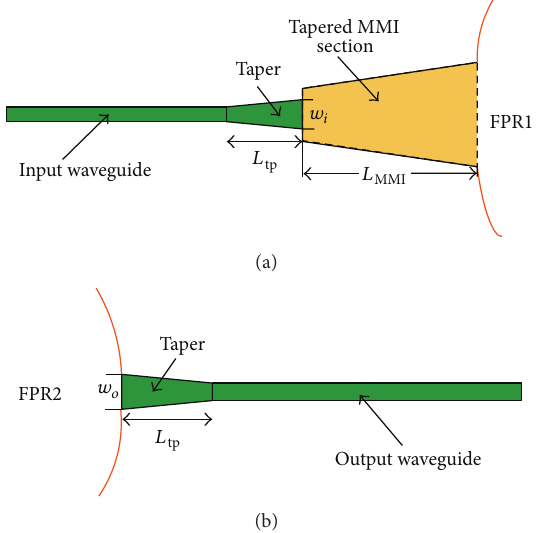
Figure 11: Structure used to flatten spectral responses: (a) section between the input waveguide and FPR1 and (b) section between the output waveguide and FPR2.